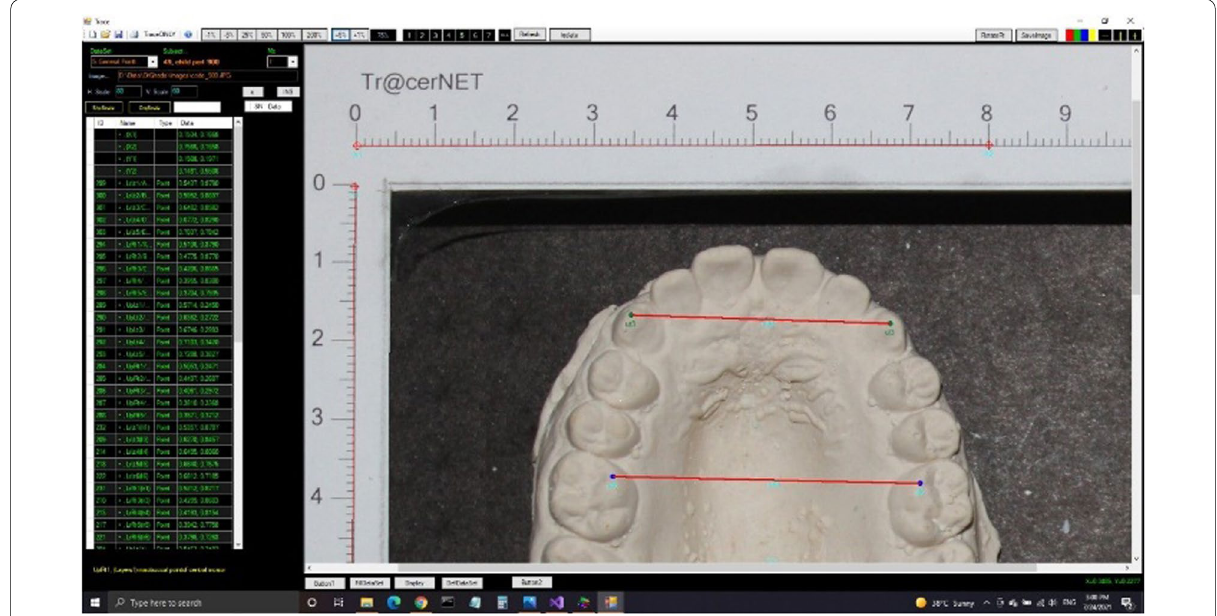
Fig. 1 The measurements of the intercanine and intermolar